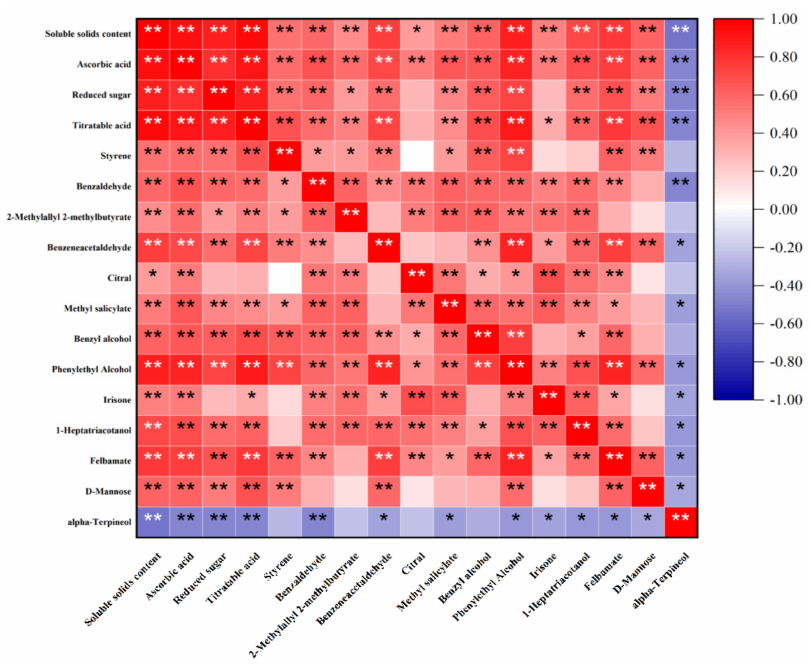
Figure 4. Correlation analysis between the potential differential metabolites and nutritional indicators of cherry tomatoes. Note: “**” indicates a highly significant difference ( p < 0.01) and “*” indicates a significant difference ( p <